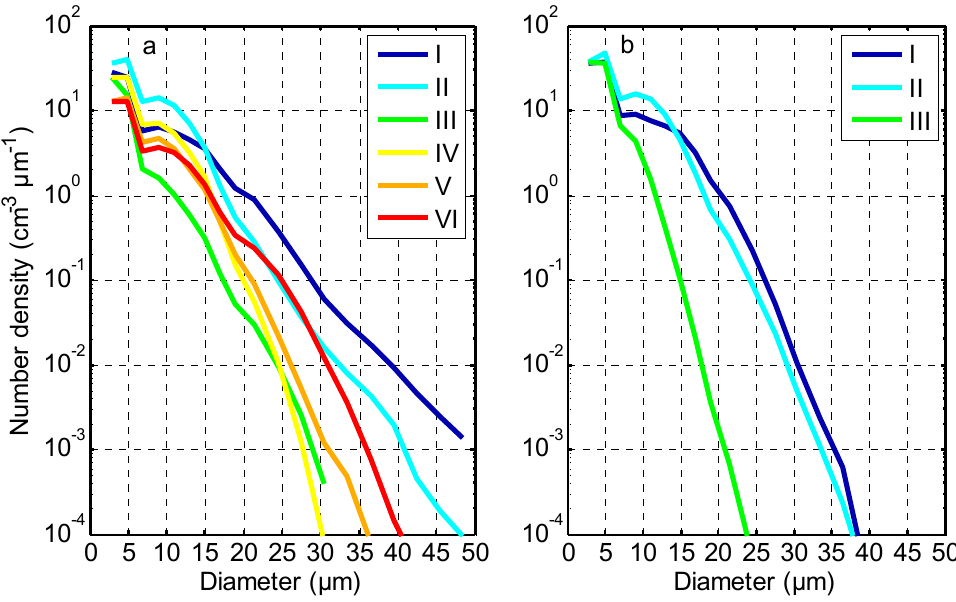
Figure 8. Average fog droplet spectrum of each phase in Figure 7: ( a ) case 2 and ( b ) case 4.